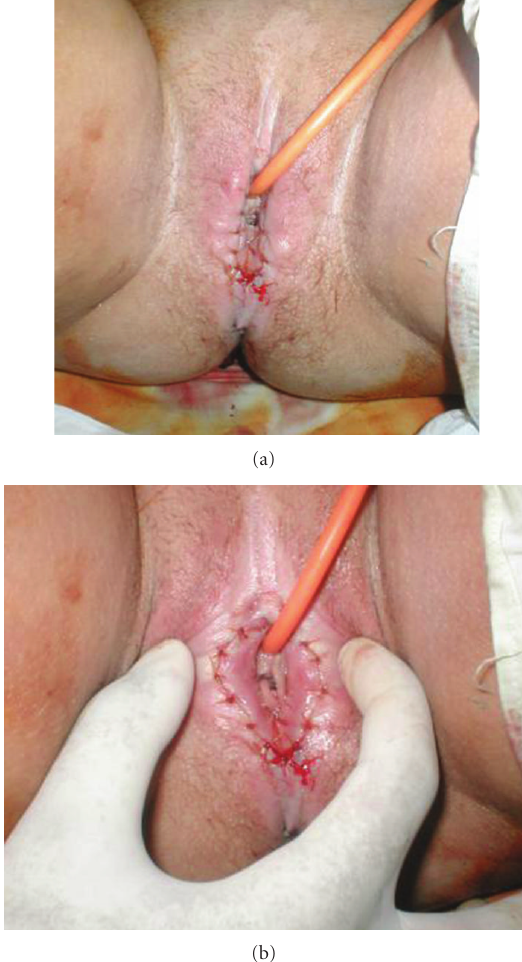
Figure 1: Preoperative photos showing adhesion with and without separation of vulva.